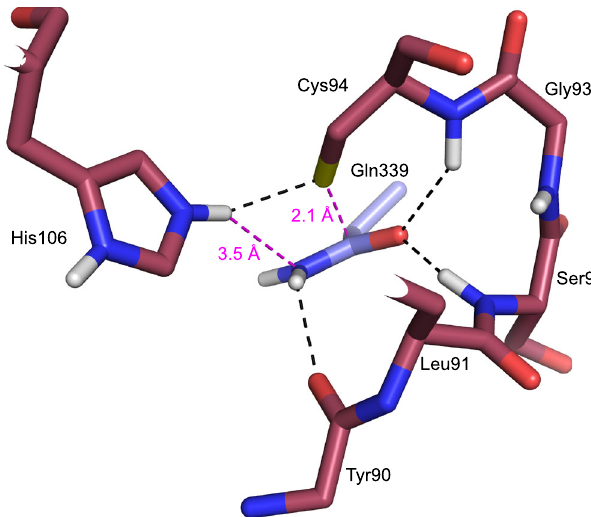
Fig. 3 Active site of hybrid WT BLF1:eIF4A Δ 20 model. In the hybrid WT BLF1: eIF4A model, the eIF4a substrate Gln339 carboxamide forms hydrogen bonds to the main chain nitrogen of BLF1 Ser92 and Cys94 (black dashes) and lies close to the main chain carbonyl of Tyr90. His106 N ε 2 donates a hydrogen bond to the sulfur of Cys94 (black dashes) and lies 3.5 Å from the side chain amide nitrogen of Gln339 with the Cys94 sulfur 2.1 Å above the amide carbon (magenta dashes). The diagram